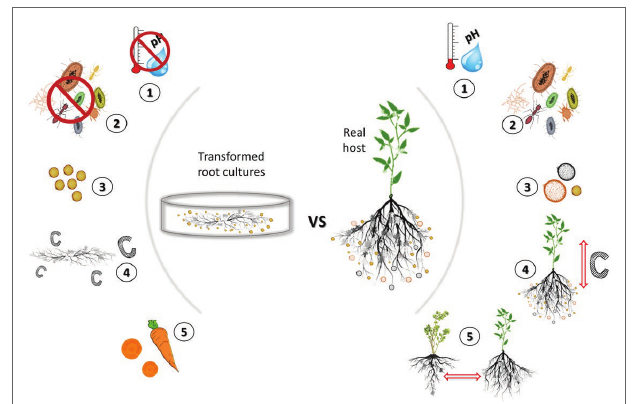
FIGURE 1 | Comparison of the artificial growing environment of transformed root cultures (TRC) to a natural environment. While TRC can produce uncontaminated and abundant AM fungal propagules, they consists a highly artificial and eutrophic environment that lacks environmental stimuli. (1) Lack of abiotic stimuli : Petri dishes are kept sealed to retain moisture and are propagated in the dark at a stable temperature that benefits the AM fungal productivity (propagule production). In a natural environment, there is continuous fluctuation of temperature, and moisture as well as high spatial variation in pH but also in multiple other abiotic factors. Such abiotic factors can affect the AM fungal growth as well as the mycorrhizal response (MR) (Wang et al., 1993; Heinemeyer and Fitter, 2004) and have seen to alter the gene expression of fungi (Meyer et al., 2017). (2, 3) Lack of biotic stimuli : the main benefit of TRC is the ability to grow AM fungi under sterile conditions that allows for uncontaminated propagation of the desired species/isolate. Each TRC contains only a single isolate of AM fungi. AM fungi have antagonistic and synergetic relations with other soil microbes (Mar Vázquez et al., 2000) as well as with other AM fungi (Wilson, 1984; Engelmoer et al., 2014). The TRC environment lacks biotic interactions that when present can lead to the production of multiple chemical compounds (Naiki and Cook, 1983; Gallone et al., 2016) that confer stress resistance or can enhance the metabolic activity of the engaged microbes (Ola et al., 2013). (4) Unrestricted carbon flow : TRC lack a shoot and therefore carbon flow to the AM fungus is consistent and continuous (Fortin et al., 2002) in contrast to a real plant where carbon flow fluctuates daily and seasonally between shoot and root (Lippu, 1998). (5) Lack of host diversity : in nature, AM fungi can interact simultaneously with multiple host. Host identity can alter significantly the gene expression of AM fungi (Mateus et al., 2019) and alter the progression of the symbiosis (Angelard et al., 2010). The dramatic reduction of host diversity and continuous re-cultivation using a sole host [most commonly carrot ( Daucus carota )] may affect the function and genetic diversity of the cultured AM